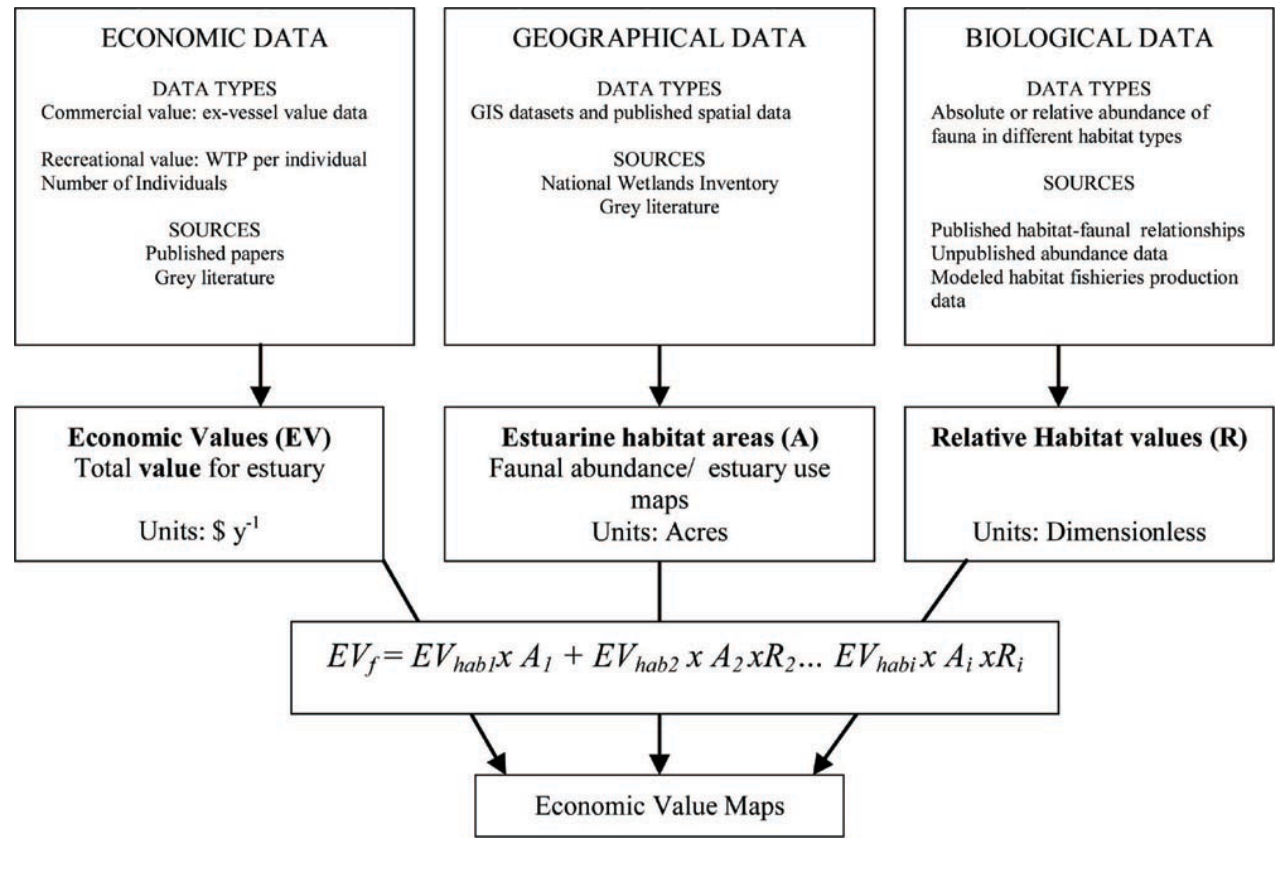
Fig. 2. Schematic diagram showing the types of data required to render economic values spatially explicit using the simple additive model along with the equation used to unite the three different kinds of